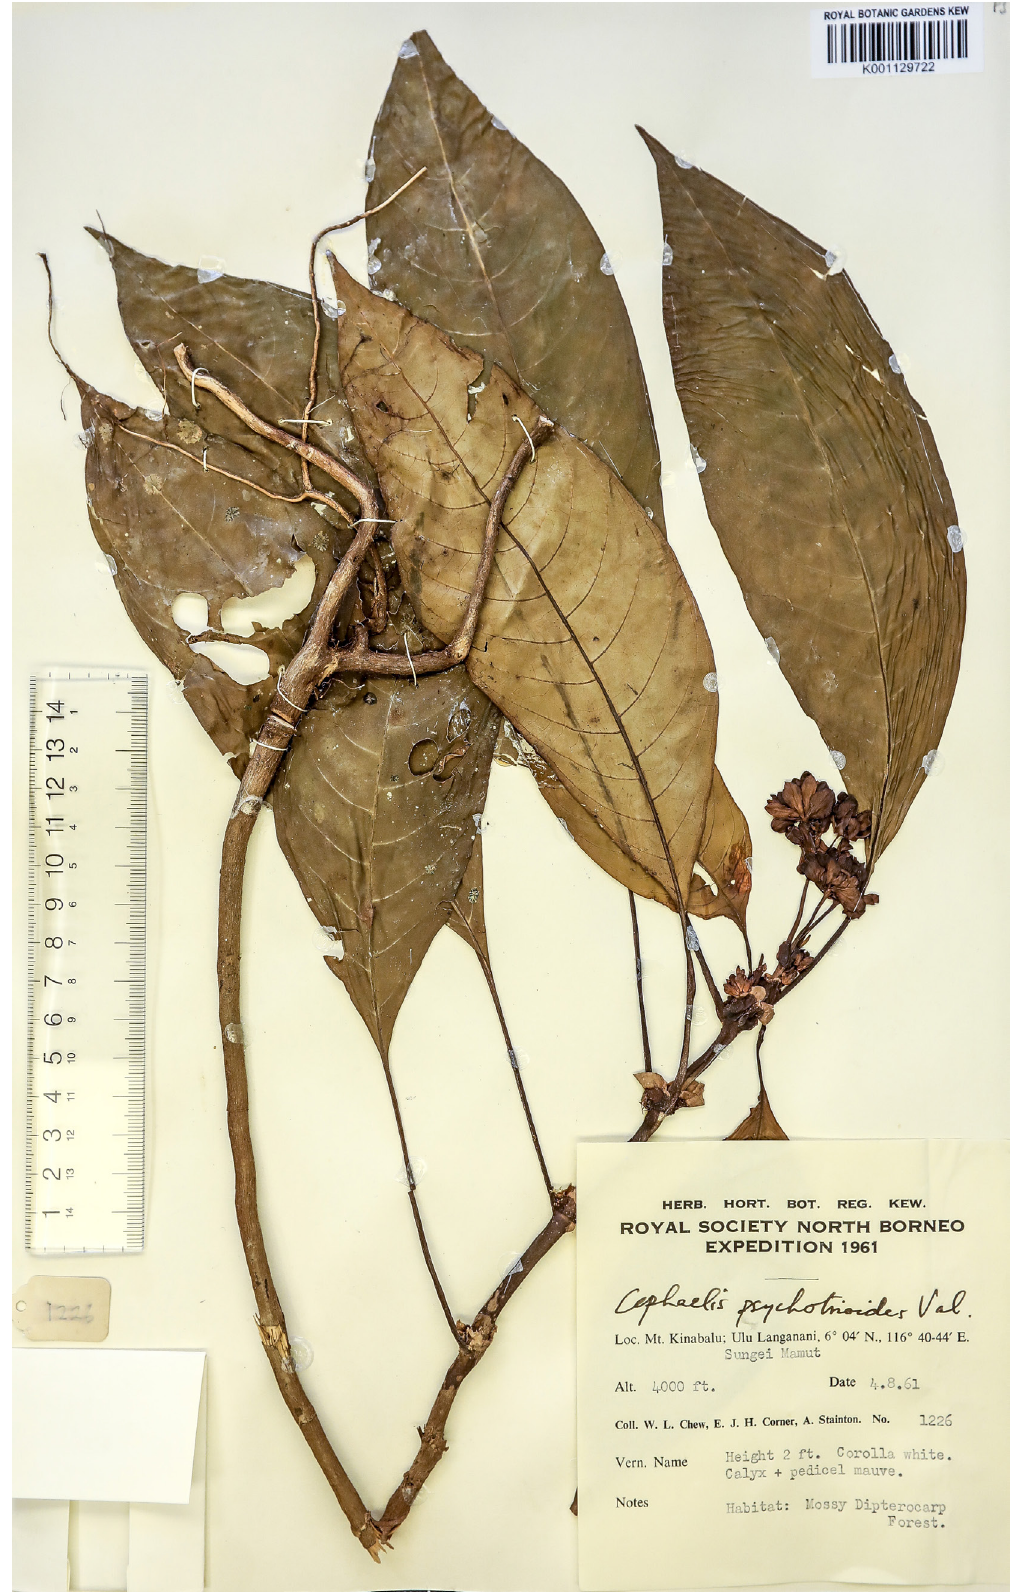
Fig. 11. Holotype of Chassalia chewii T.Y.Yu sp. nov. ( W.L. Chew, E.J.H. Corner & A. Stainton 1226